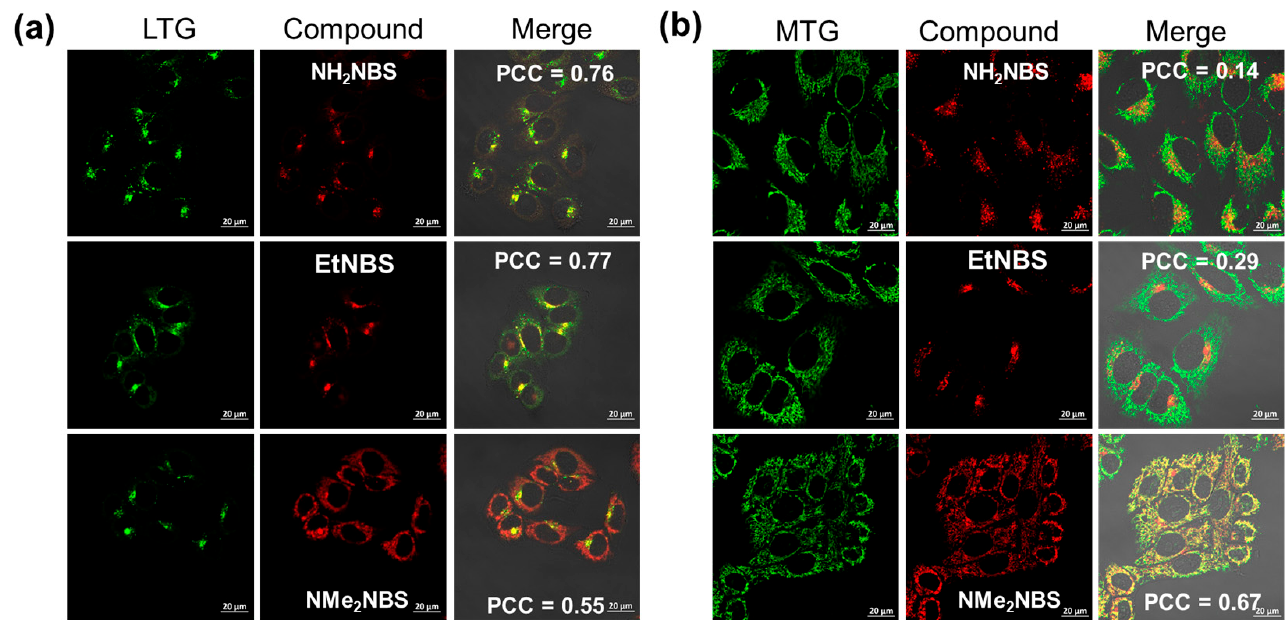
Figure 2. Subcellular localization of NH 2 NBS, EtNBS, and NMe 2 NBS (100 nM, λ ex = 633 nm, λ em = 650–750 nm). ( a ) LTG: LysoTracker Green DND 26 (75 nM, λ ex = 488 nm, λ em = 500–550 nm). ( b ) MTG: Mito-Tracker Green (200 nM, λ ex = 488 nm, λ em = 500–550 nm).